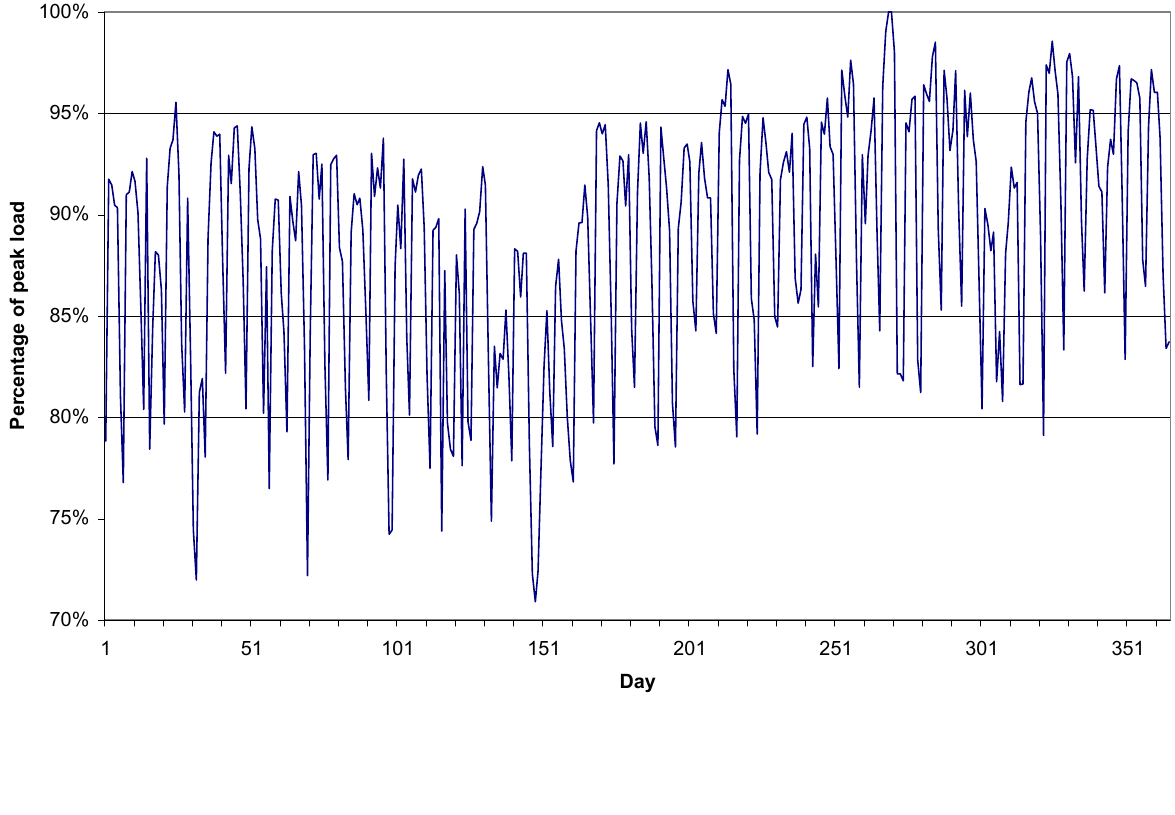
Figure 5. Daily maximum demand of Sabah electrical grid from 1 September 2008 to 31 August 2009 (Note: 100% load corresponding to 704